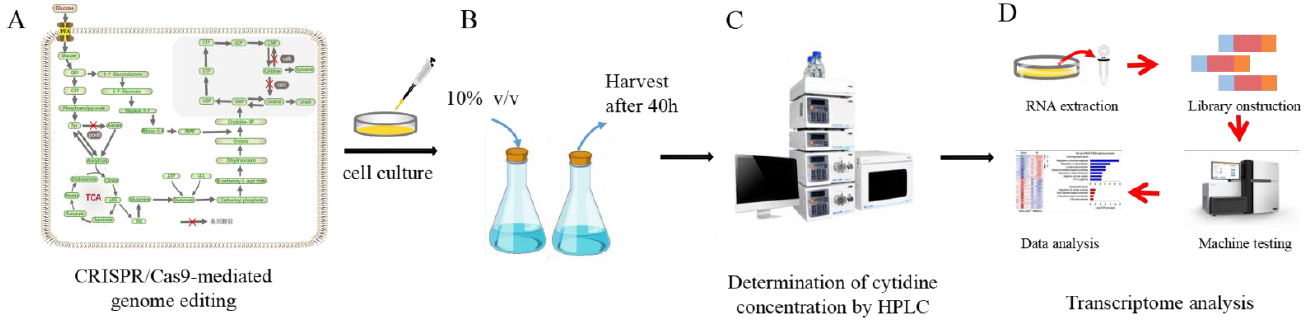
Figure 1. Schematic diagram of relevant experimental processes of this study. ( A ) Strategy of strain transformation used in this study. ( B ) Shake-flask fermentation experiment. ( C ) Determination of cytidine concentration by HPLC. ( D ) Transcriptome analysis process.